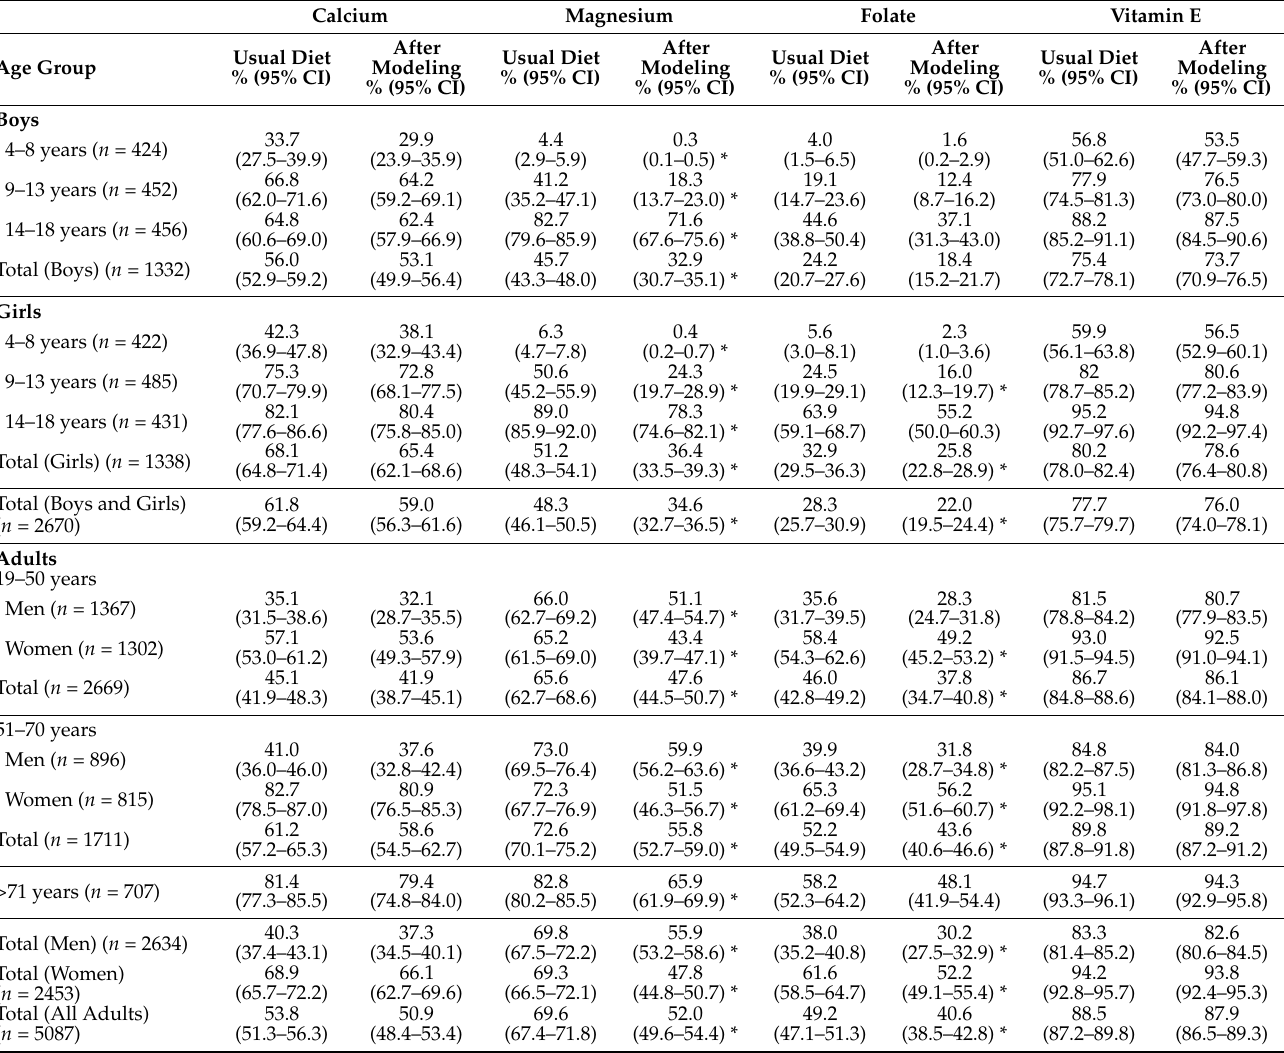
Table 3. Percentage of individuals with nutrient intakes below the EAR a at usual (current) and modeled intakes (addition of 1 ounce of